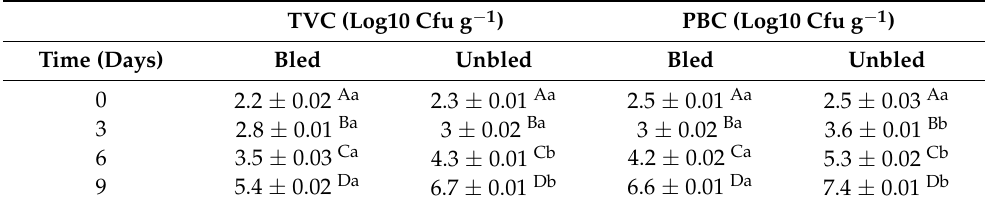
Table 1. Changes in the total viable count (TVC) and psychrophilic bacterial count (PBC), in bled and unbled African catfish during fridge